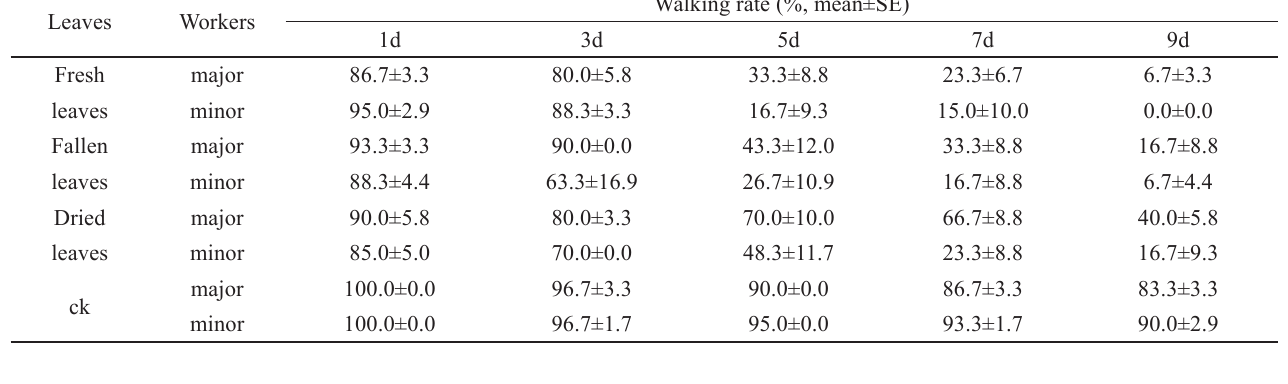
Table 4. Effects on walking rate of workers after treated with mashed fresh, fallen, and dried leaves of M. exotica.